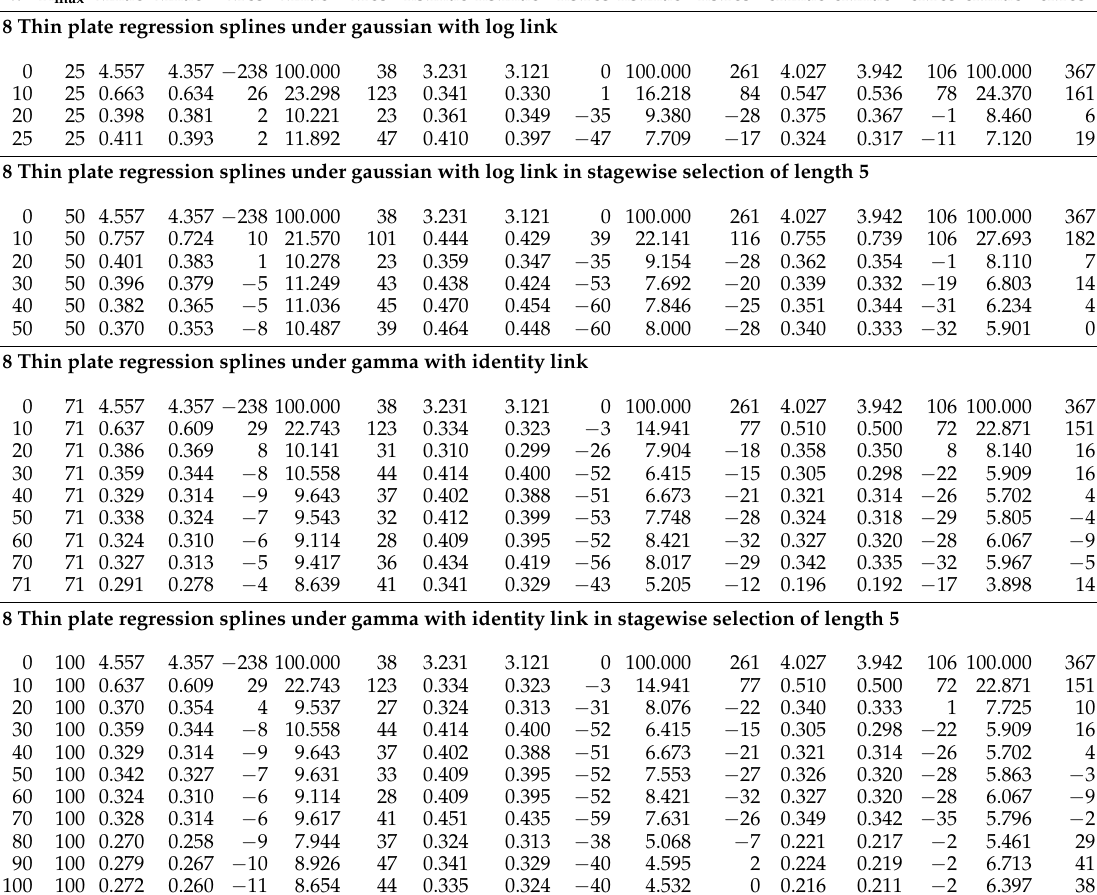
Table A21. Out-of-sample validation figures of selected GAMs of BEL in adaptive forward stepwise and stagewise selection of length 5 under between 25–443 and 100–443 after each tenth and the finally selected smooth